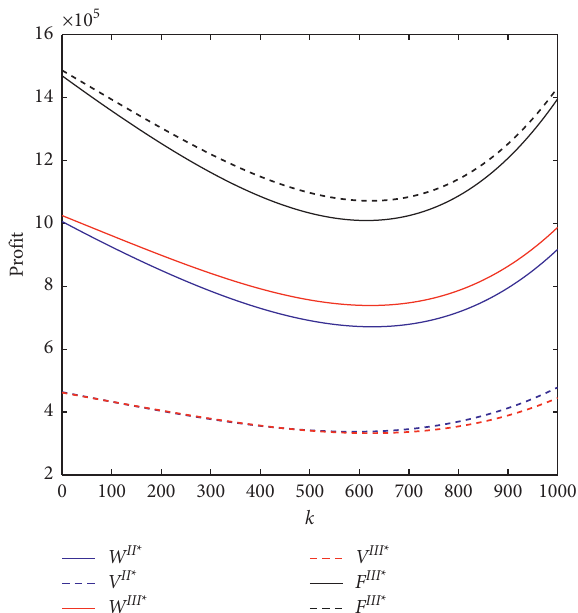
Figure 7: The effects of k on